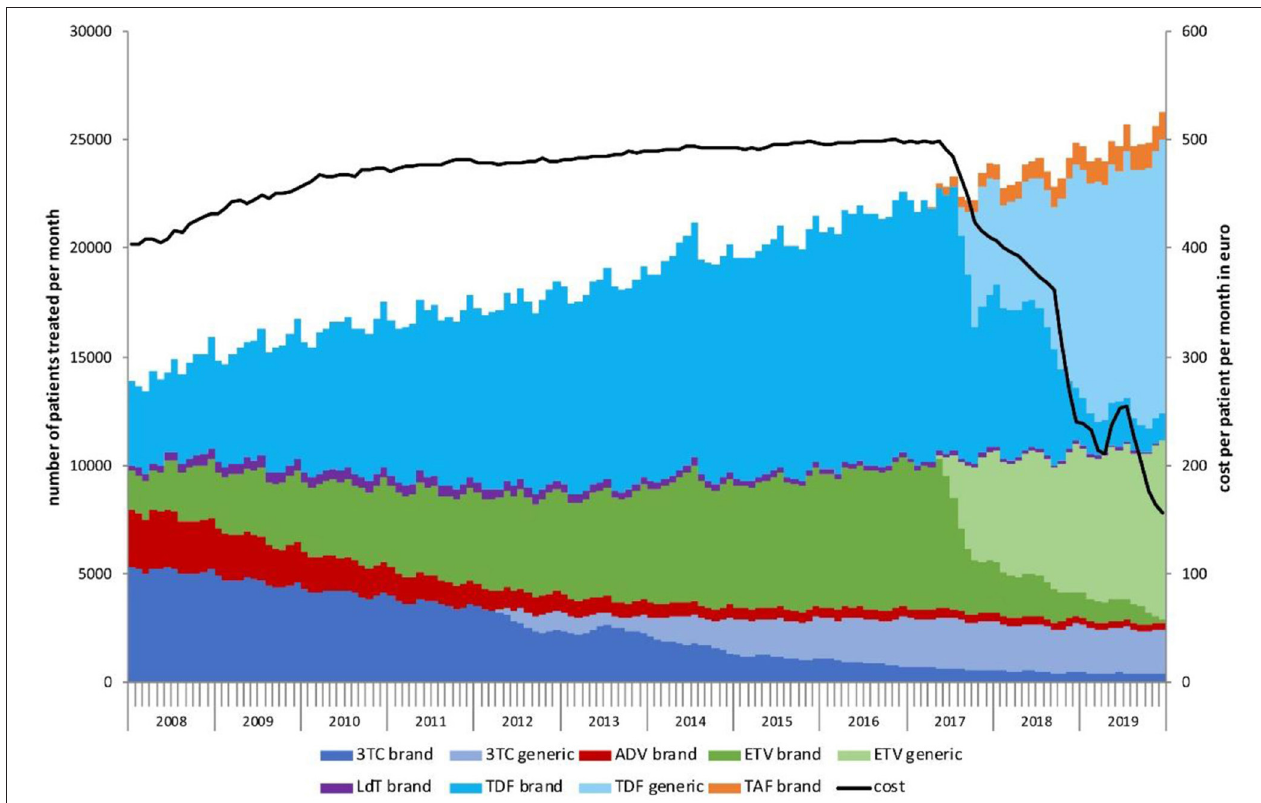
FIGURE 1 | Number of chronic hepatitis B patients treated per month by drug, 2008–2019. The black line shows the cost per patient per month in Euro.